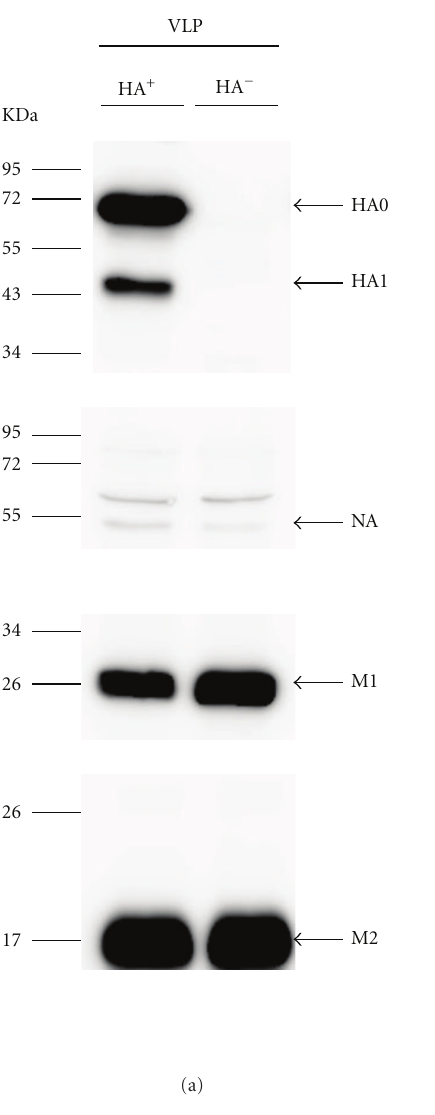
Figure 2: Characterization of insect cell-derived VLP. Equal amounts of VLP proteins were resolved by 12.5% discontinuous SDS polyacrylamide gel and detected by four di ff erent primary antibodies against HA, NA, M1, M2 (a). The morphology and particle size distribution of HA + VLP were measured by transmission electron microscope (b) and dynamic light scattering (c),